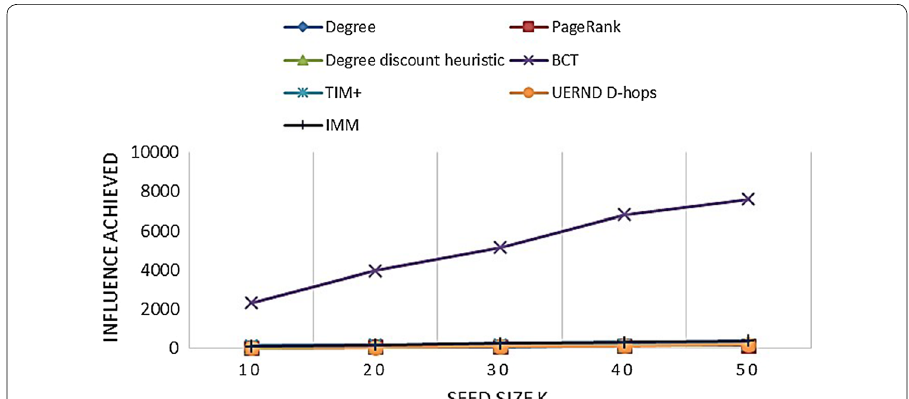
Fig. 3 Influence spread under LT model for Nethept data. Degree PageRank Degree discount heuristic BCT TIM UERND D-hops IMM +